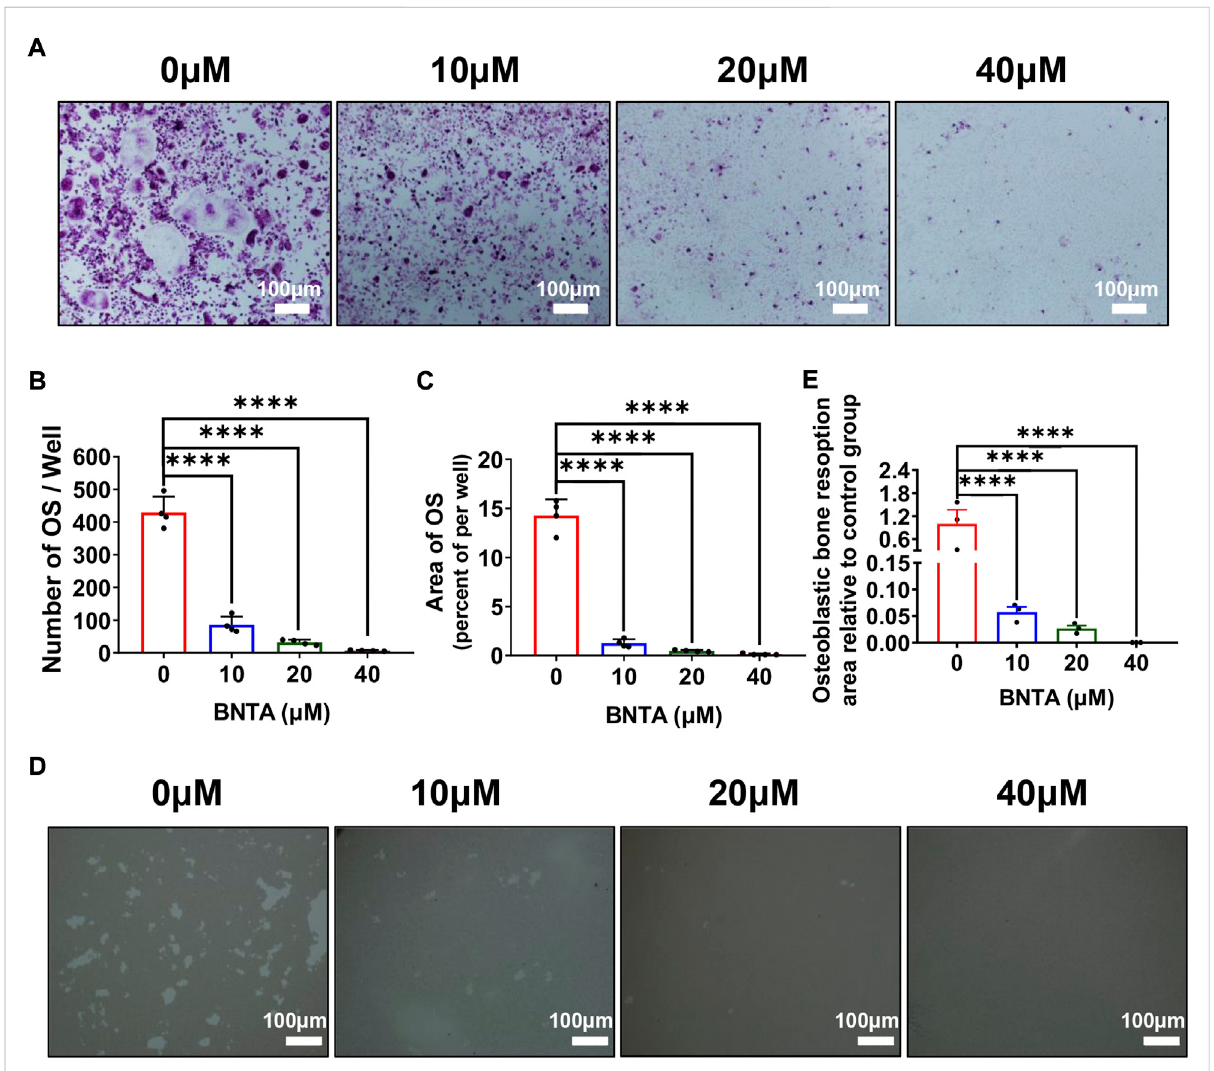
BNTA inhibited RANKL-induced osteoclastogenesis and osteolysis in vitro . (A) Representative images of BMMs stained for TRAP showed BNTA inhibited osteoclastogenesis in a dose-dependent manner. BMMs were stimulated by RANKL for 5 days with or without indicated concentrations of BNTA. (B,C) Quanti fi cation of TRAP-positive multinucleated cells (nuclei ≥ 3) ( n = 4 per group). All data are presented as mean ± SD. **** p < 0.0001 compared with control group. (D) Representative images of hydroxyapatite resorption in each group presented BNTA inhibited osteolysis dose-dependently. BMMs were stimulated by RANKL for 5 days with or without indicated concentrations of BNTA. (E) Quanti fi cation of resorbed hydroxyapatite area per well. ( n = 3 per group). All data are presented as mean ± SD. **** p < 0.0001 compared with control